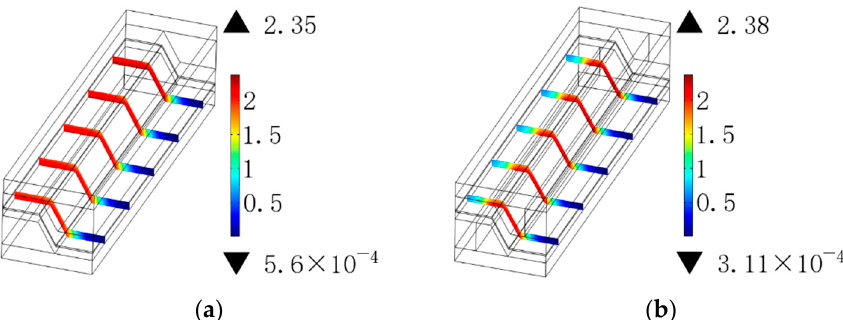
Figure 7. Oxygen concentration distribution: ( a ) conventional design; ( b ) vertical rib design (unit: mol/m 3 ).